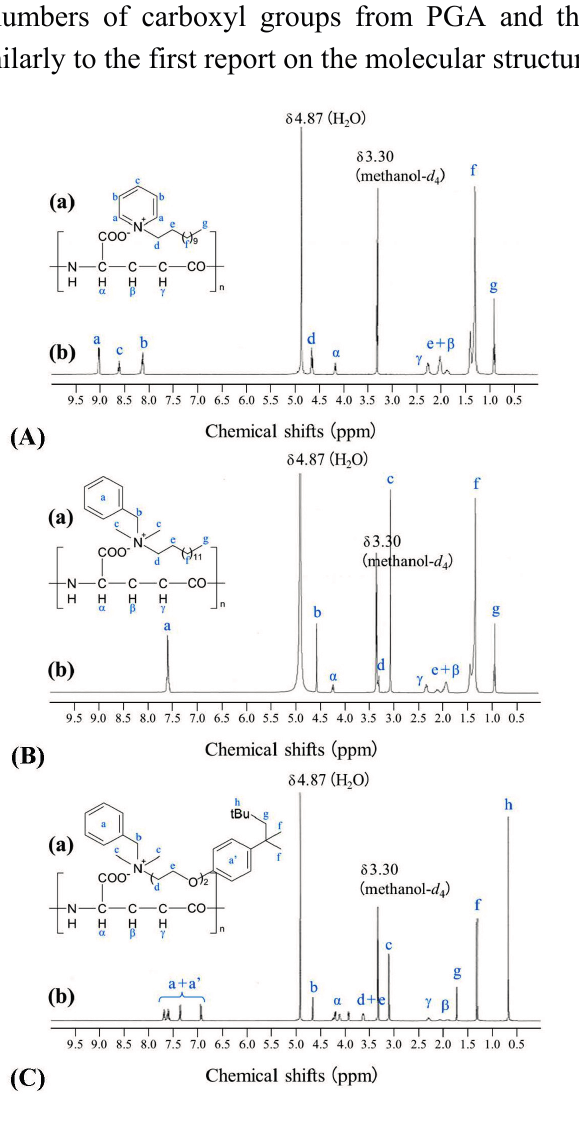
Figure 2. ( a ) Predicted chemical structures and ( b ) liquid 1 H-NMR analysis of new